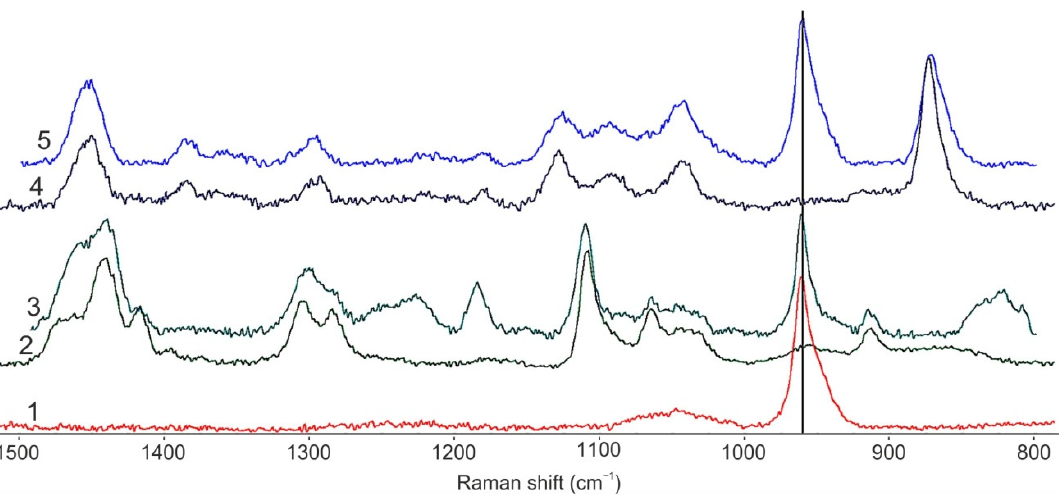
Figure 10. Raman spectra of initial nHA (1), PCL (2) and PCL-based microparticles contained nHA at polymer/nHA ratio of 1/1 (3); initial PLA (4) and PLA-based microparticles contained nHA at polymer/nHA ratio of 1/1 (5).